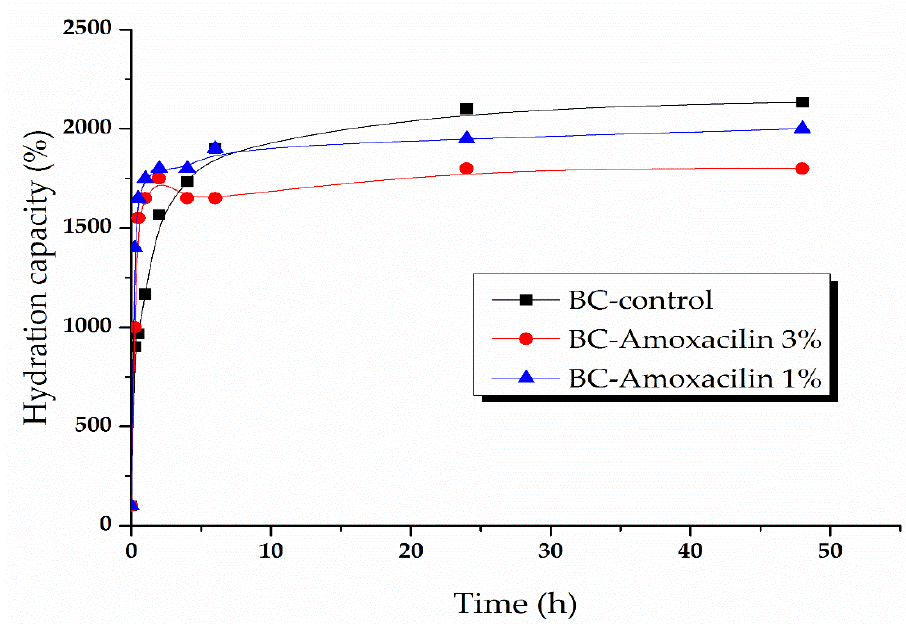
Figure 8. Absorption kinetics of BC samples loaded with amoxicillin 1% and 3%.